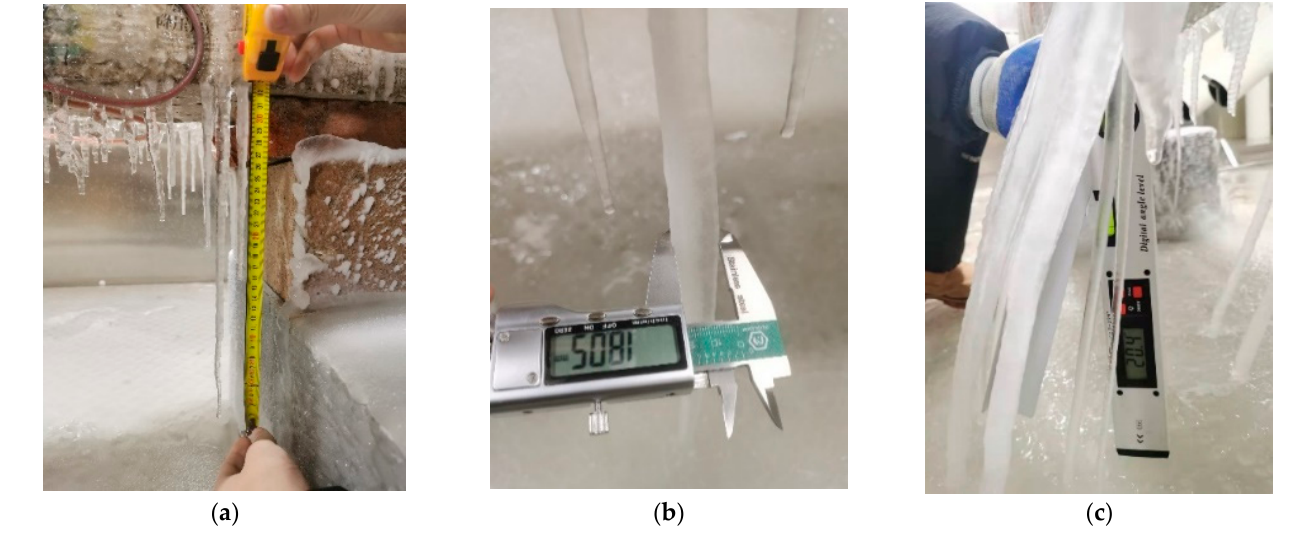
Figure 6. Diagram for measuring the dimensions of each icicle: ( a ) length, ( b ) diameter, and ( c ) tilt angle.